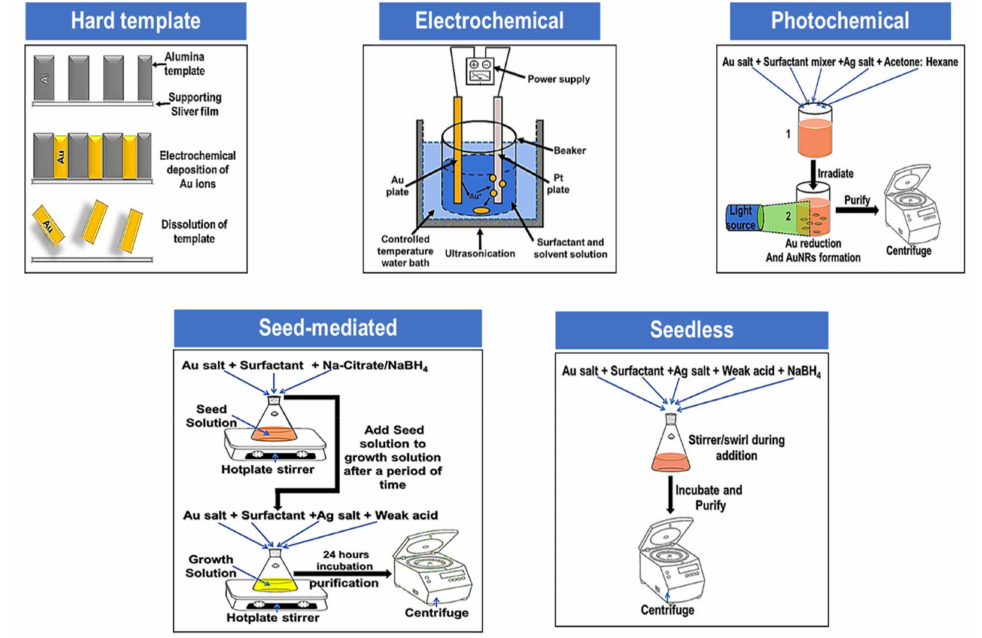
Figure 2. Schematic diagram of di ff erent AuNRs synthetic